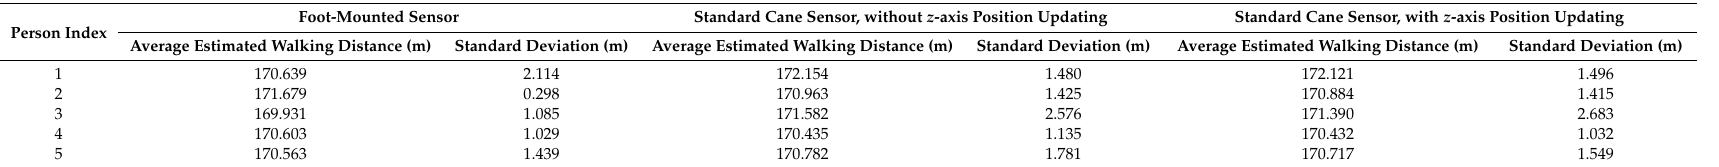
Table 4. Estimated walking distance from 170-meter experiment with standard